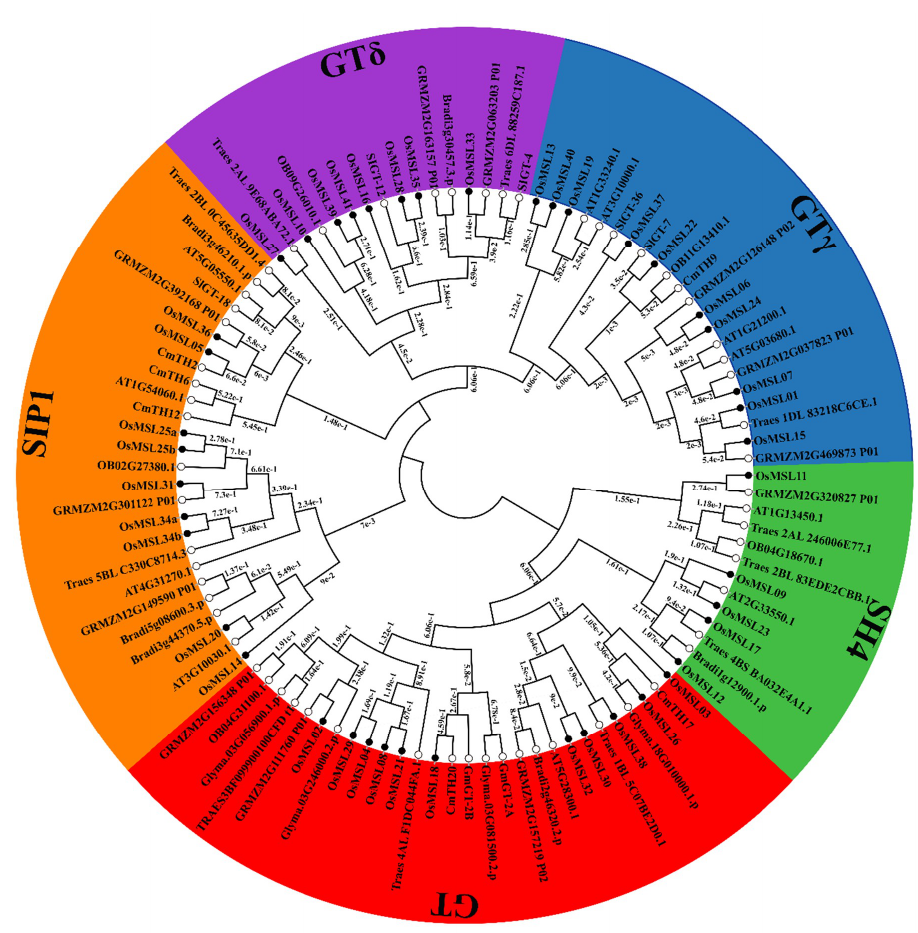
Figure 4. Phylogenetic relationships among 105 trihelix proteins in rice, Arabidopsis , soybean, maize, tomato, wheat, chrysanthemum, wild rice and Brachypodium distachyon . The maximum likelihood tree was created using MEGA v. 7.0 (bootstrap value = 1000) and the bootstrap value of each branch is displayed. Forty-three OsMSL proteins are marked with black circles and other species are marked with white circles. The phylogenetic tree was clustered into SIP1, GTγ, GT, SH4, and GTδ.